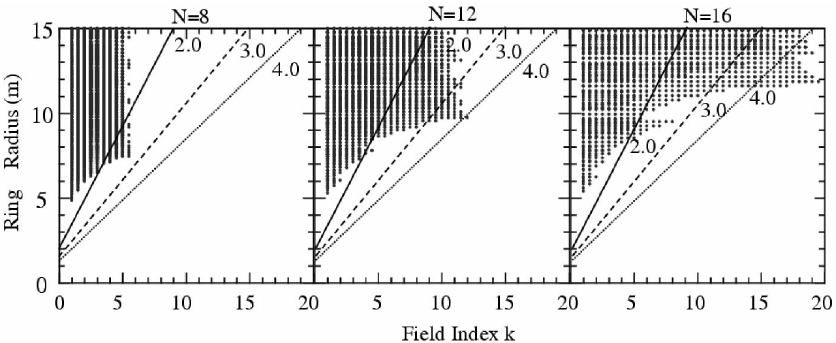
FIG. 4. Ring radii calculated for the first stability region of 8, 12, and 16 cells. Doublet radial-sector configurations are assumed. Straight lines correspond to momentum ratios of 2.0, 3.0, and 4.0, respectively, where orbit excursions are less than 1